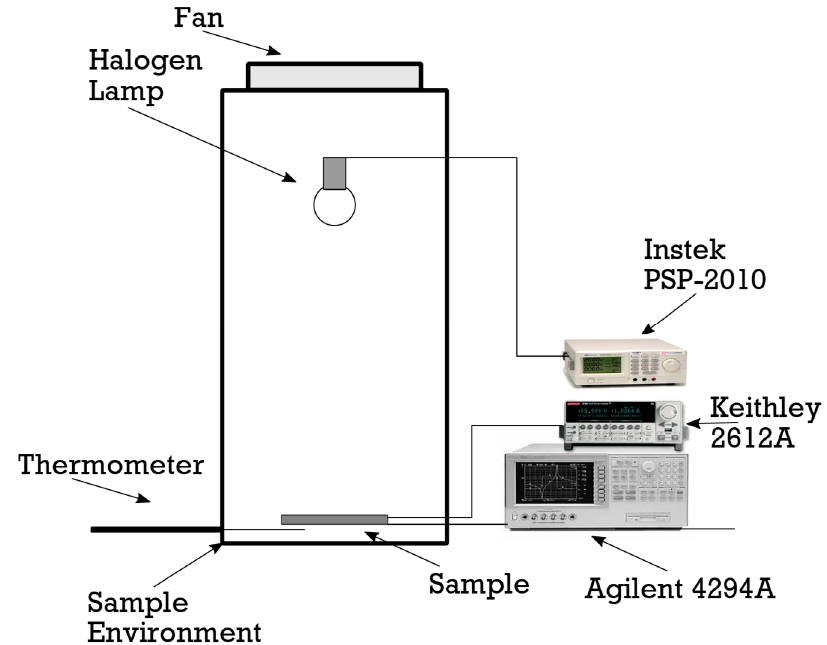
Figure 4. Experimental setup.